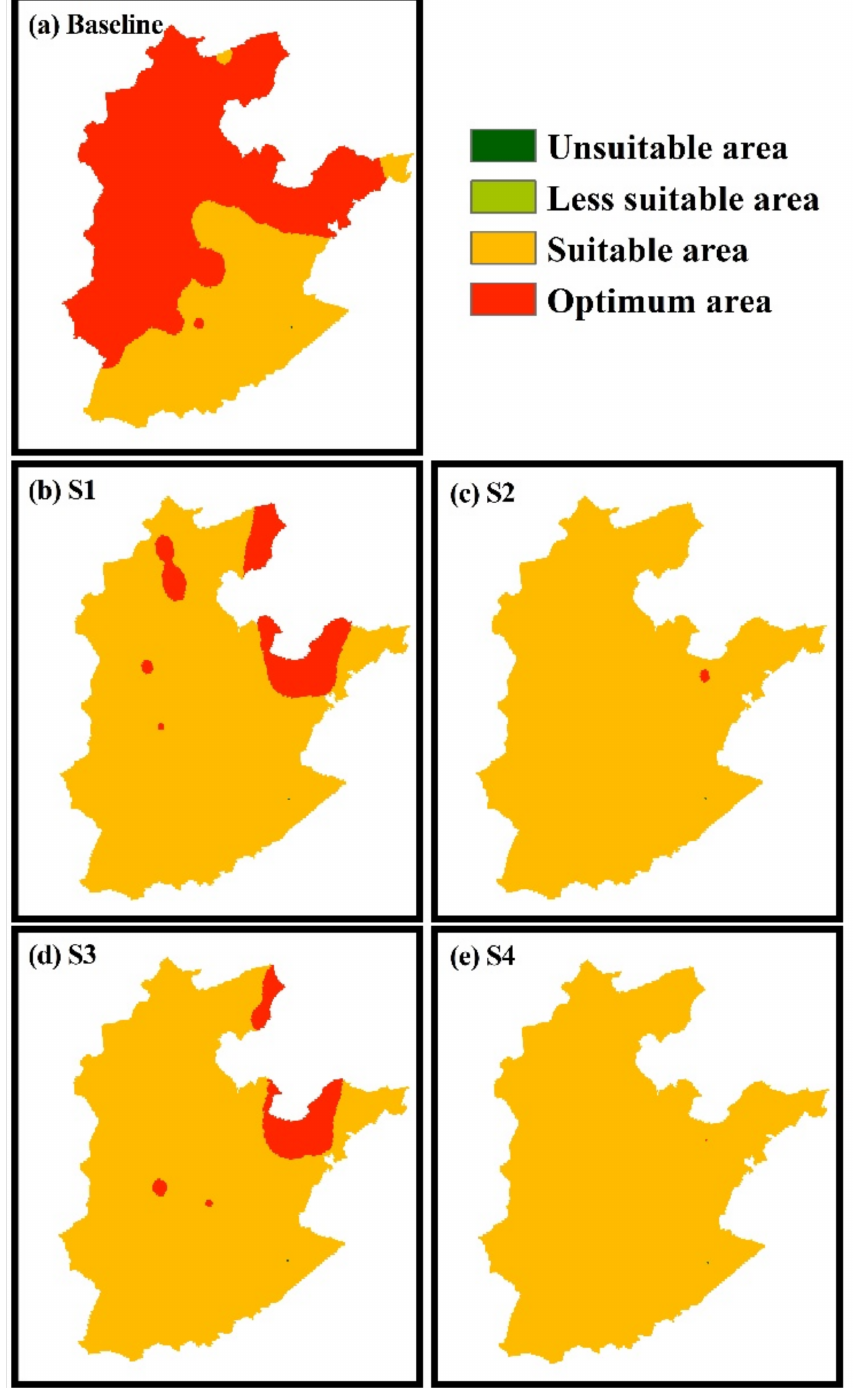
Figure 7. Regional division of climate suitability for maize during the baseline period (1981–2010) ( a ) and four future scenarios ( b – e ) in the